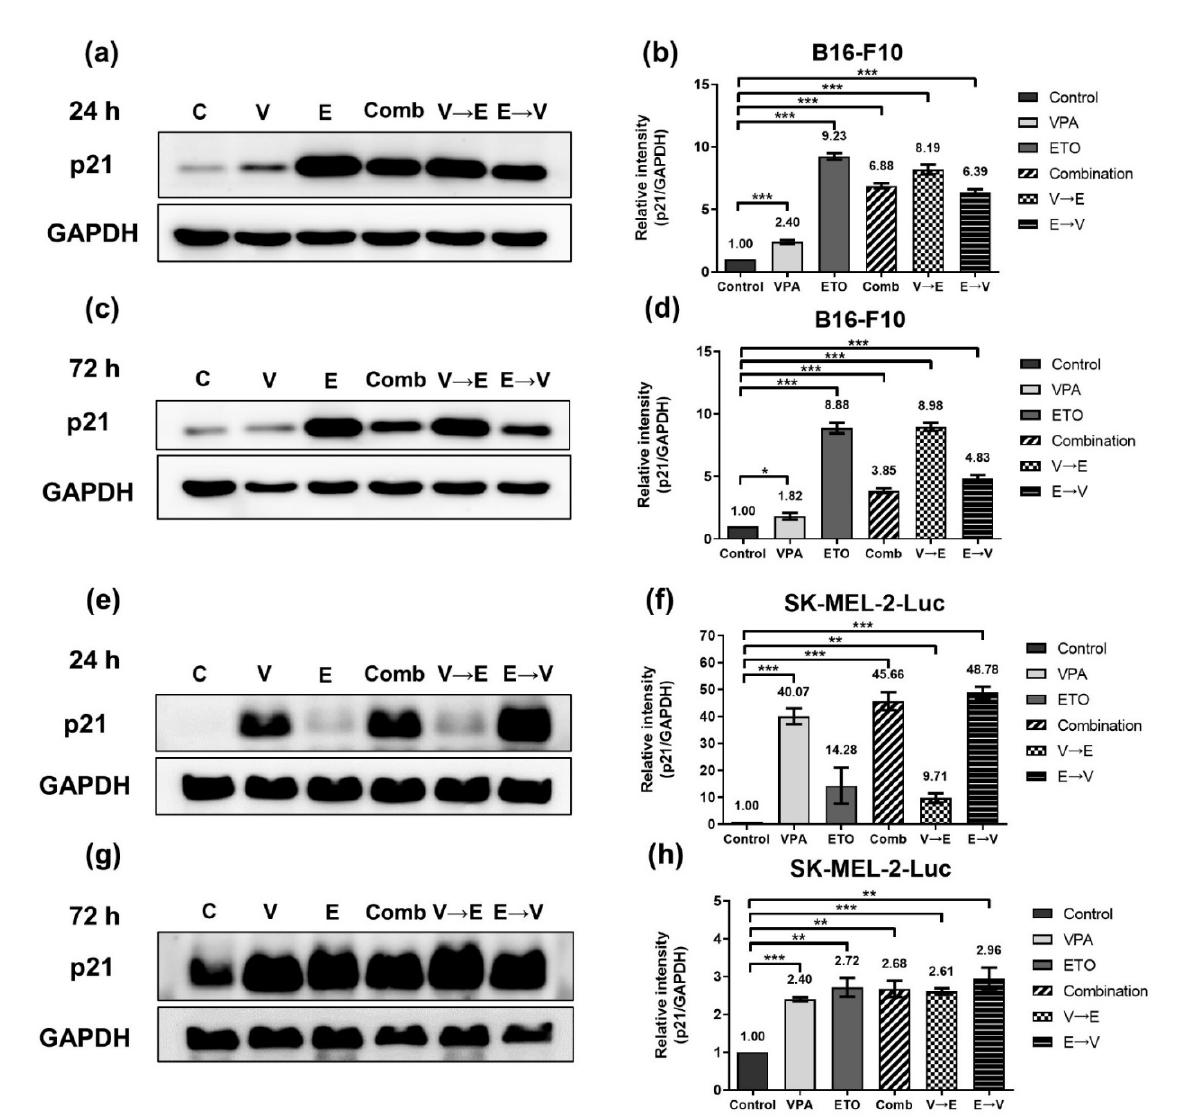
Figure 13. Expression of cell cycle regulator p21, under single, simultaneous, and sequential combined treatments of VPA and ETO in melanoma cells. Western blot analysis illustrated the p21 protein expression after ( a ) 24 h ( c ) 72 h single, simultaneous, and sequential combined treatments of VPA and ETO in B16-F10 cells. ( b , d ) was quantitative analysis of ( a , c ), respectively, which was obtained by using Image J software 1.52a (National Institutes of Health, Bethesda, MD, USA). The analysis was repeated in SK-MEL-2-Luc cells. Western blot data of ( e ) 24 h and ( g ) 72 h was shown, and the corresponding quantitative analysis was shown in ( f , h ), respectively. GAPDH was used as the control of sample loading. Relative intensities of p21 to GAPDH expressions were normalized with the control. The data are shown as means ± SEM of independent experiments in triplicate. (* p < 0.05; ** p < 0.01; *** p < 0.001). The drug dosages were referred to IC 50 values as shown in Figure 2 and Table 1.